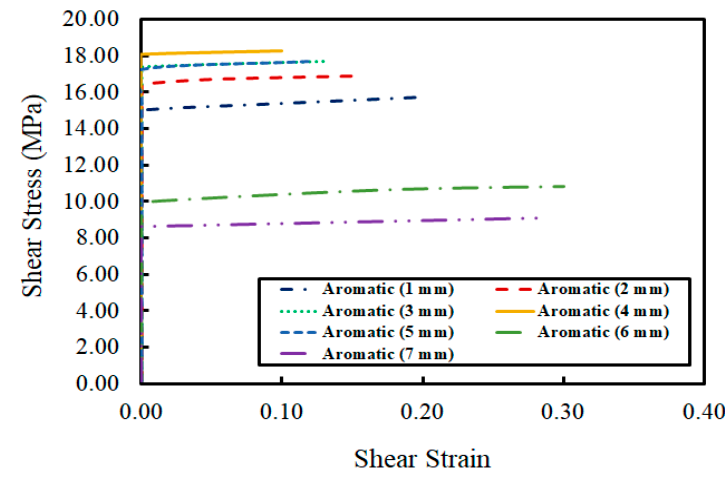
Figure 8. Relationship between shear strain and shear stress for Adhesive 3.